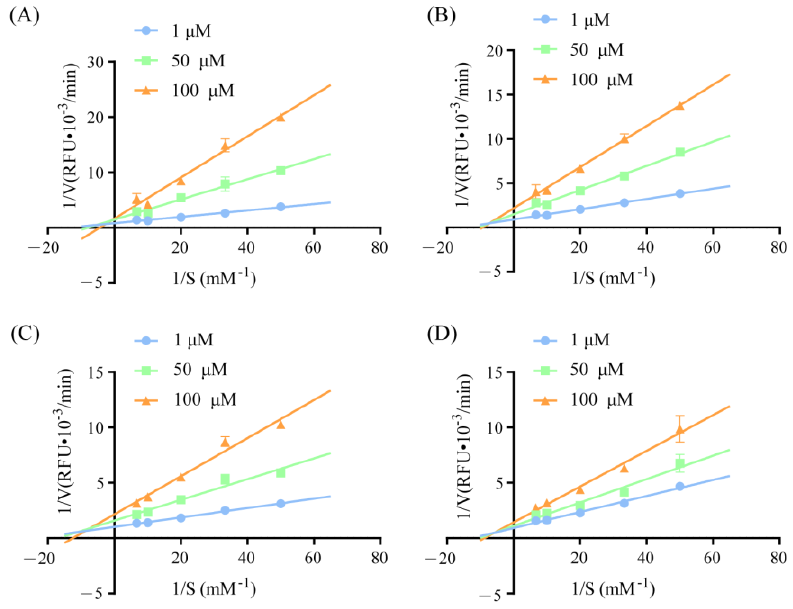
Figure 3. Inhibition mode of peptide IPQHY ( A ), VPQHY ( B ), VAVVPF ( C ), and VPLGGF ( D ) on